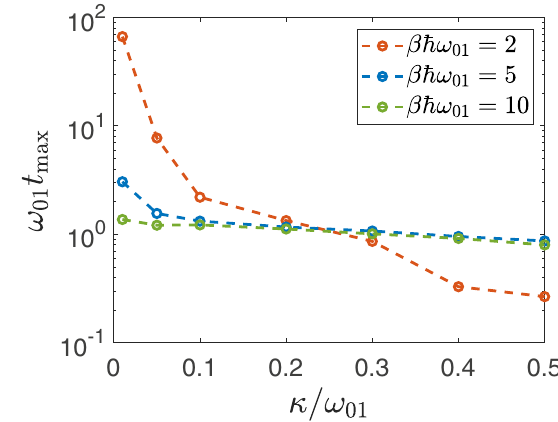
Fig. 4 The time at which maximum state leakage occurs for different coupling strengths and temperatures. The system